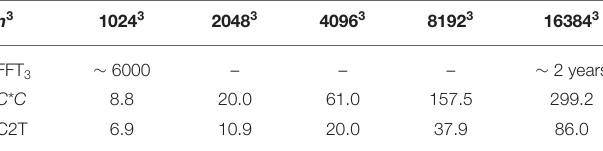
TABLE 1 | Times (sec) for the C2T transform and the 3D tensor product convolution vs. 3D FFT